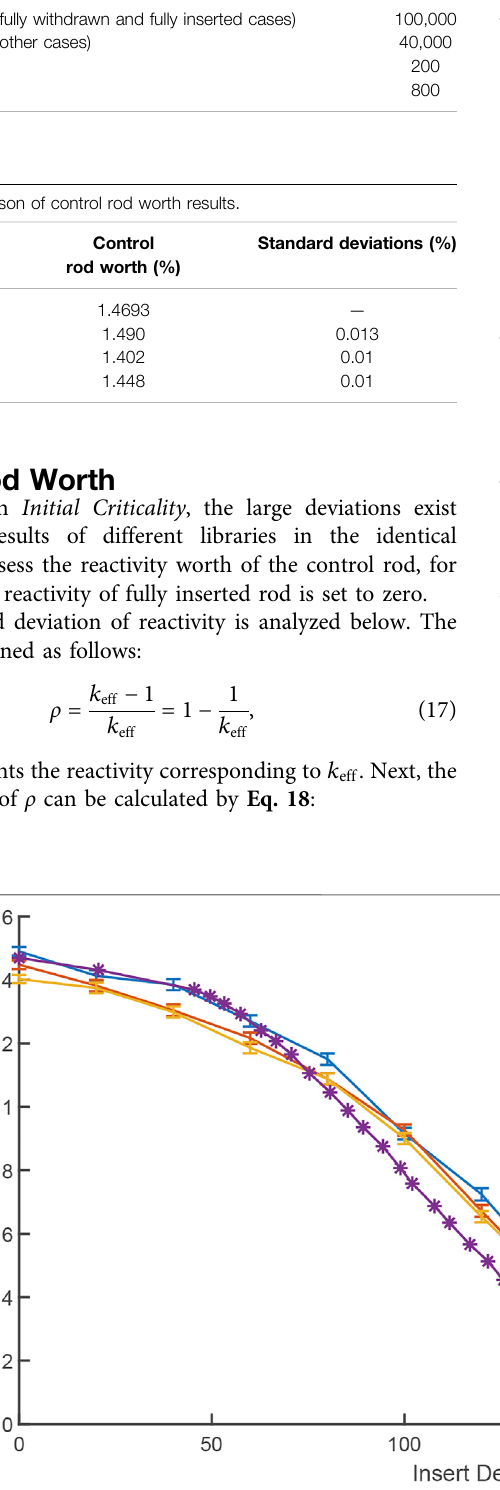
FIGURE 5 | Reactivity worth of control rod